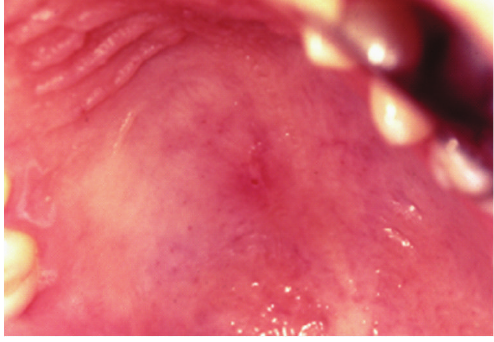
Figure 4: After one month the lesion